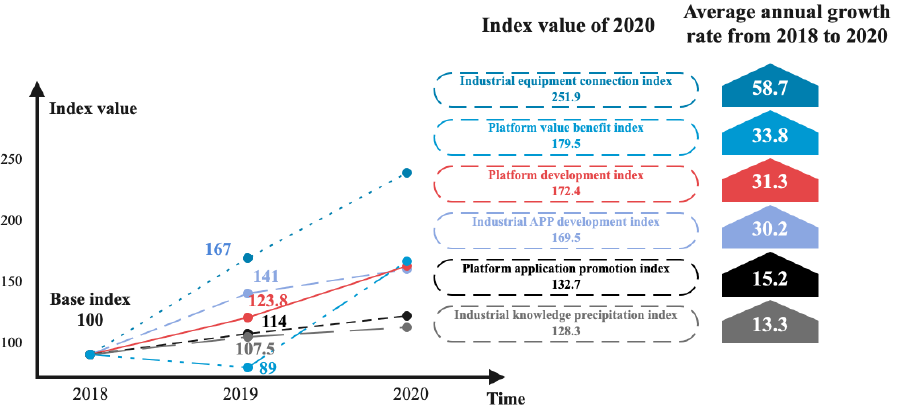
Figure 2. Development Index and Segmentation Index of Industrial Internet Platform in 2018–2020.